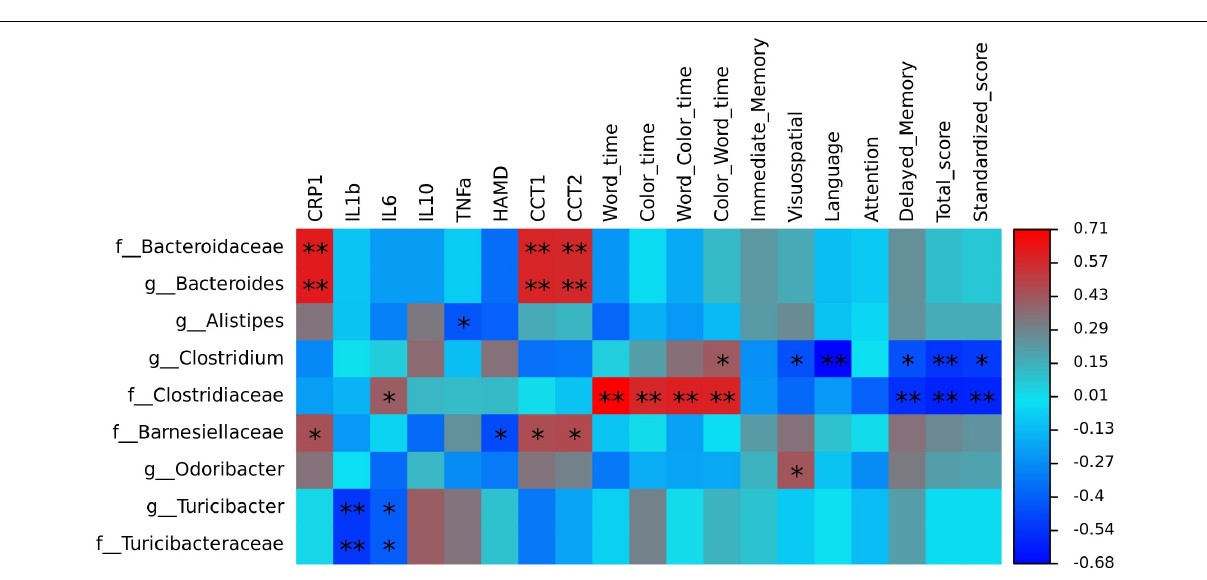
FIGURE 7 | The heatmaps of spearman correlation coefficient matrix between significant different gut bacteria and inflammatory factors, cognitive function. Red indicates positive correlations, while blue indicates negative. * P < 0.05 and ** P < 0.01. Note: HAMD, Hamilton’s Depression Scale; CRP, C-reactive protein, IL-1 β , interleukin 1 β ; IL-6, interleukin 6; IL-10, interleukin 10; TNF- α , tumor necrosis factor α ; CTT, Color Trail